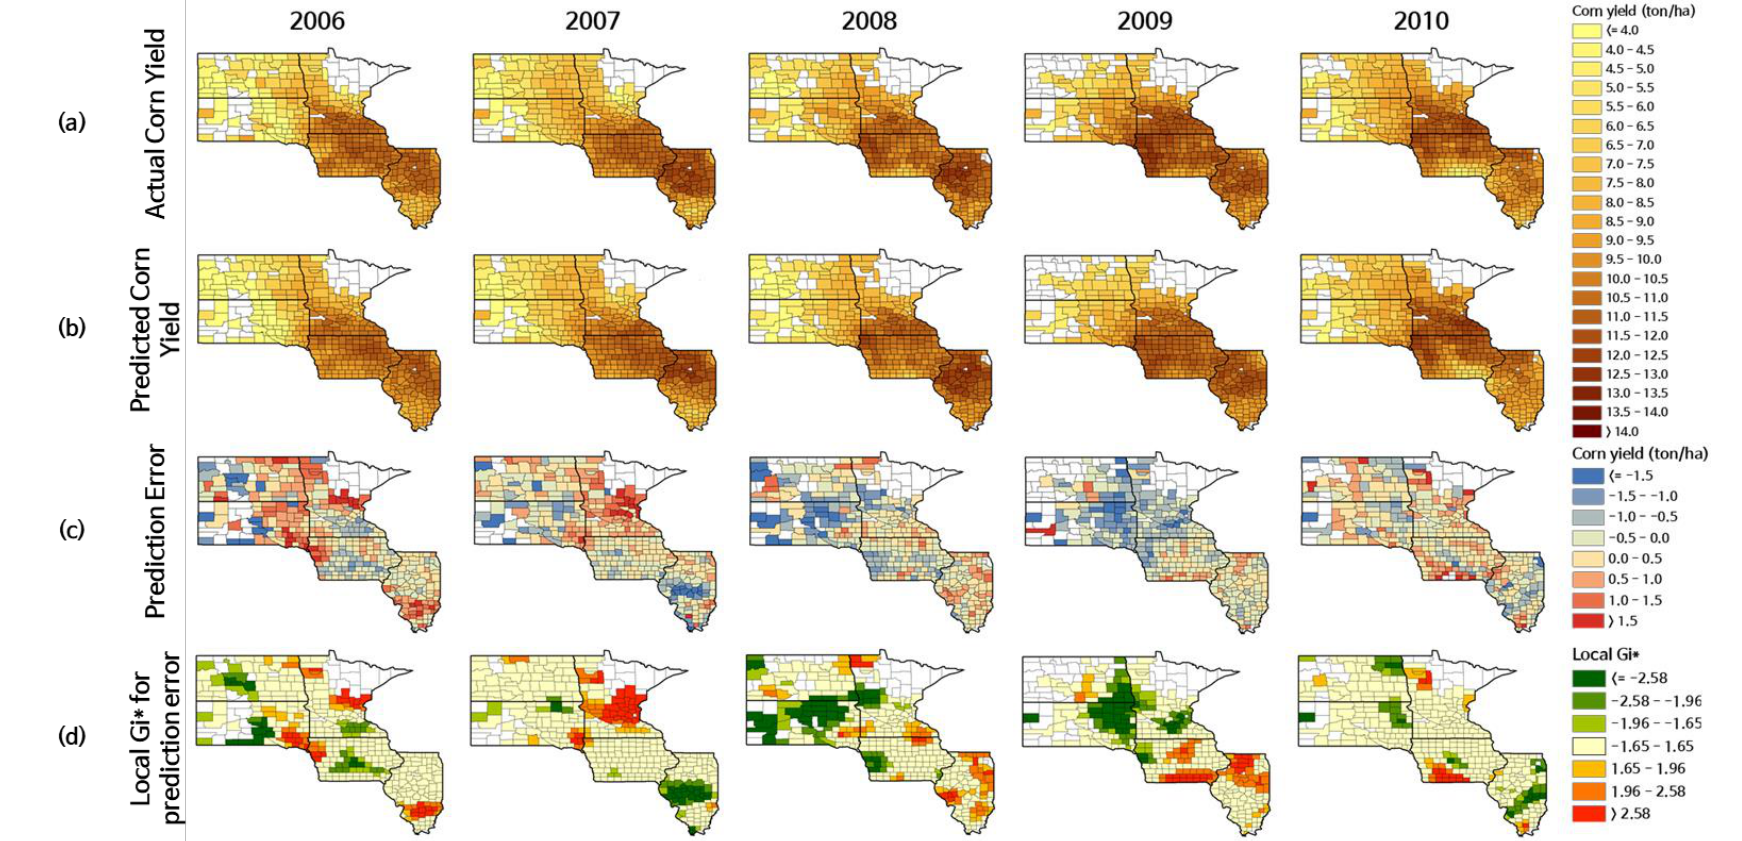
Figure 7. Maps of the actual and predicted corn yields, prediction errors, and Local Geary index (Gi*) of the prediction errors, 2006 – 2010.